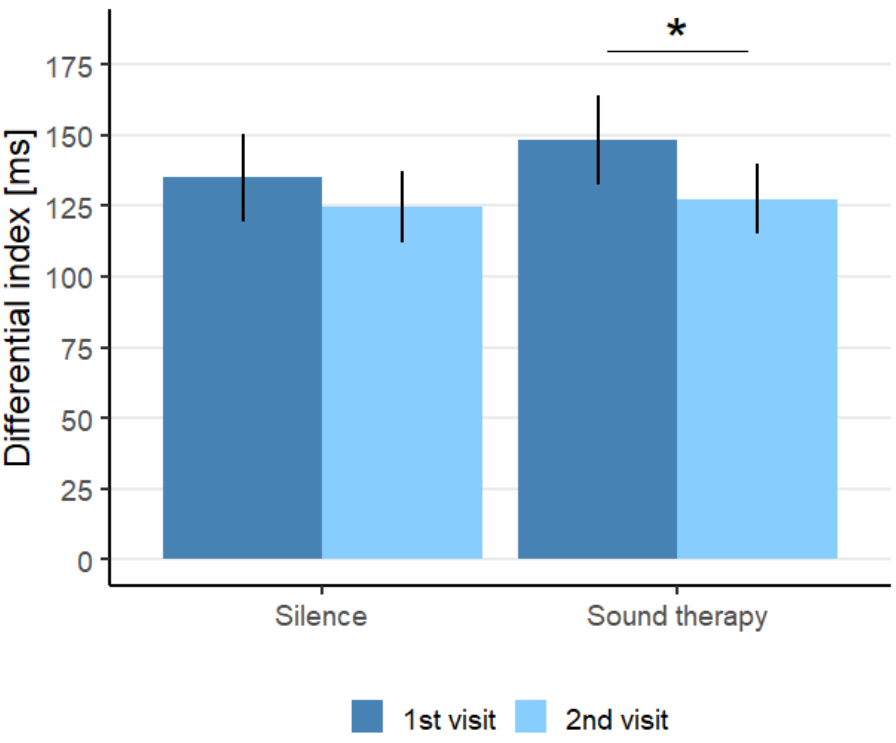
Figure 5. The differential indexes calculated based on RTs for the executive control attention networks for the tinnitus group in first visit (dark blue) and second visit (light blue) in both the silent and ST conditions. * p < 0.05. Error bars represent standard errors of the mean.